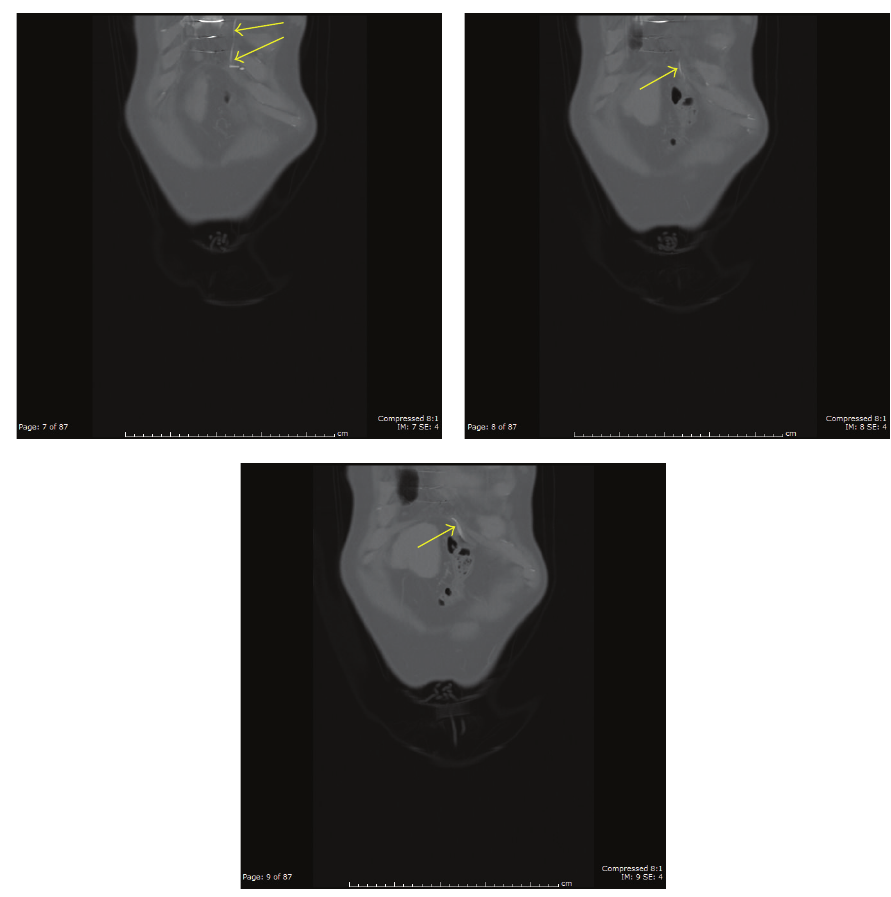
Figure 7: Coronal images with bone window following the course of the migrating epicardial pacing wire (yellow arrows).